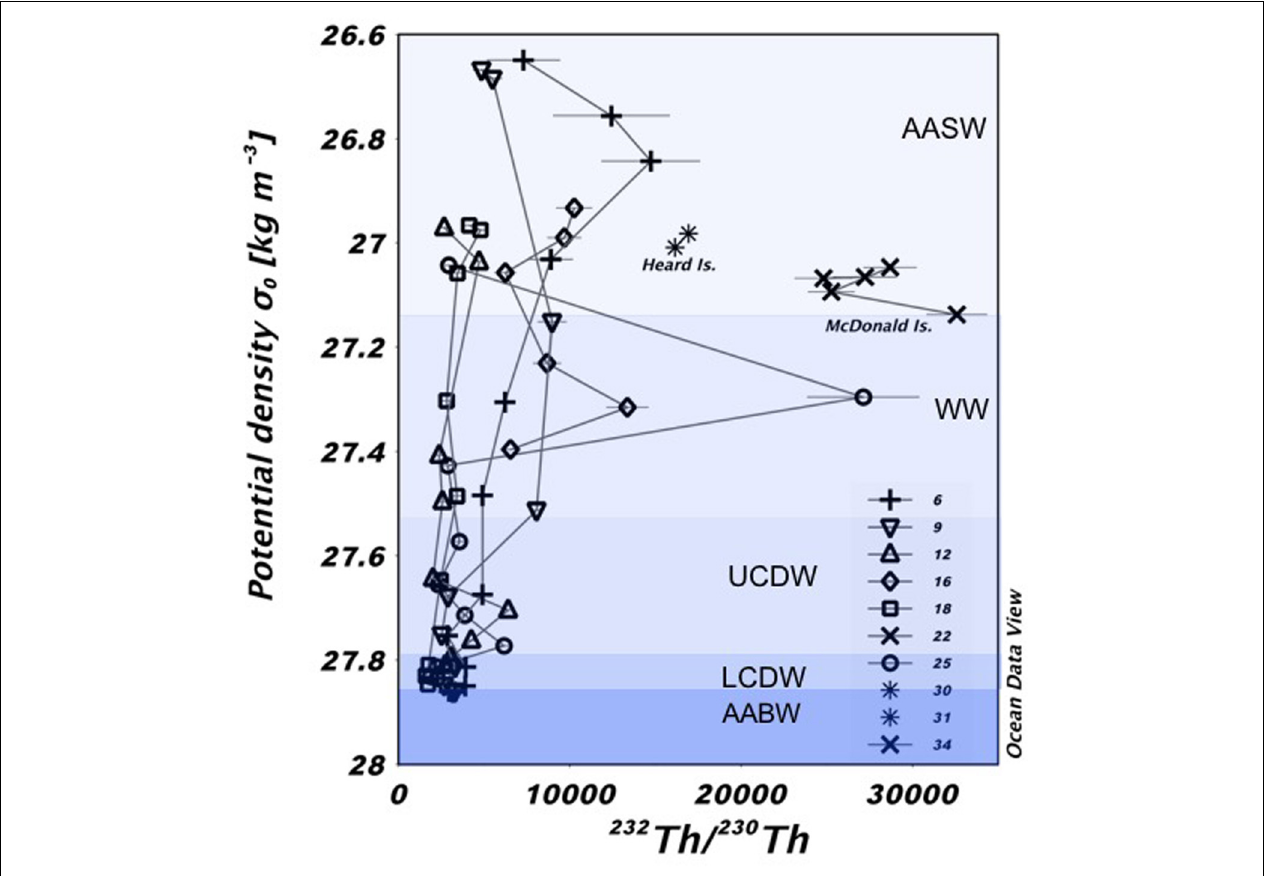
FIGURE 6 | 232 Th/ 230 Th ratio plotted against potential density anomaly for the HEOBI samples. Different background shading indicates the different water masses present during the HEOBI sampling campaign. The analytical standard error of many of the samples are smaller than the symbol. Note that the bottom sample of each station was collected ∼ 10 m above the